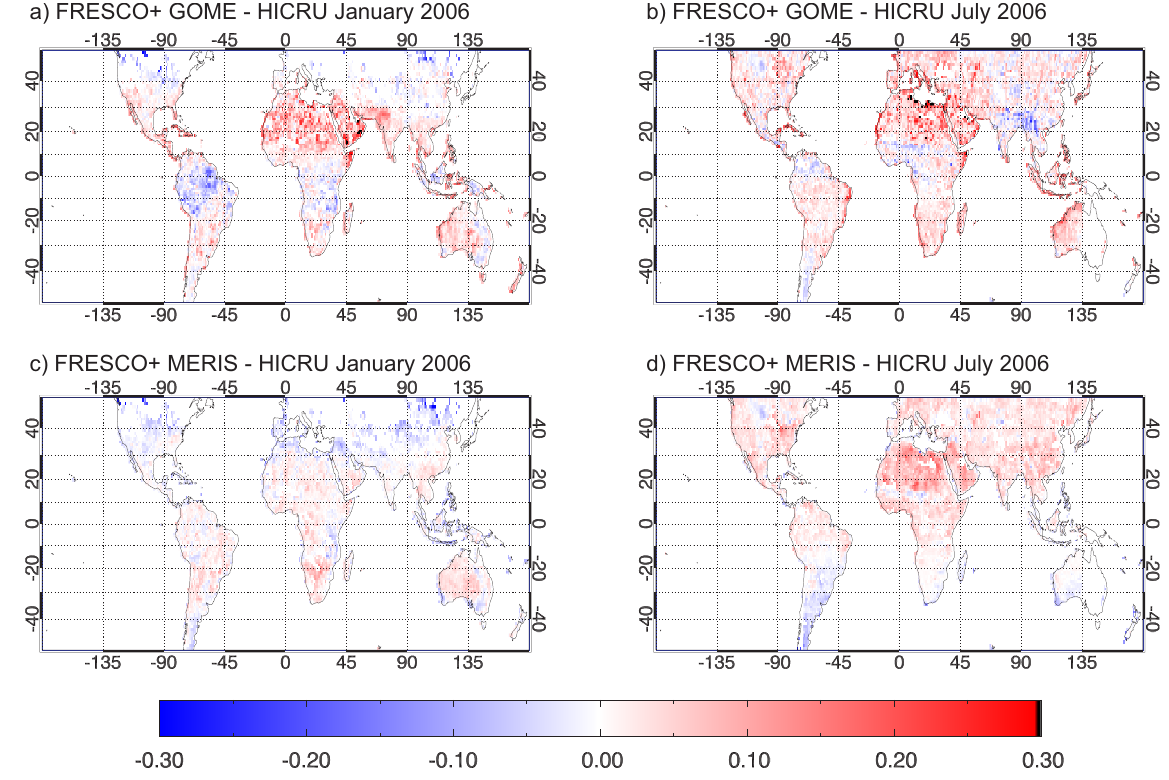
Fig. 10. Difference maps of monthly averaged effective cloud fractions per 1 ◦ × 1 ◦ grid box between FRESCO+ (GOME (upper plots) and MERIS (lower plots)) and HICRU cloud fractions for January and July 2006. FRESCO+ effective cloud fractions are converted to a cloud albedo of 0.9 and only cloud fractions < 0.8 are considered (see